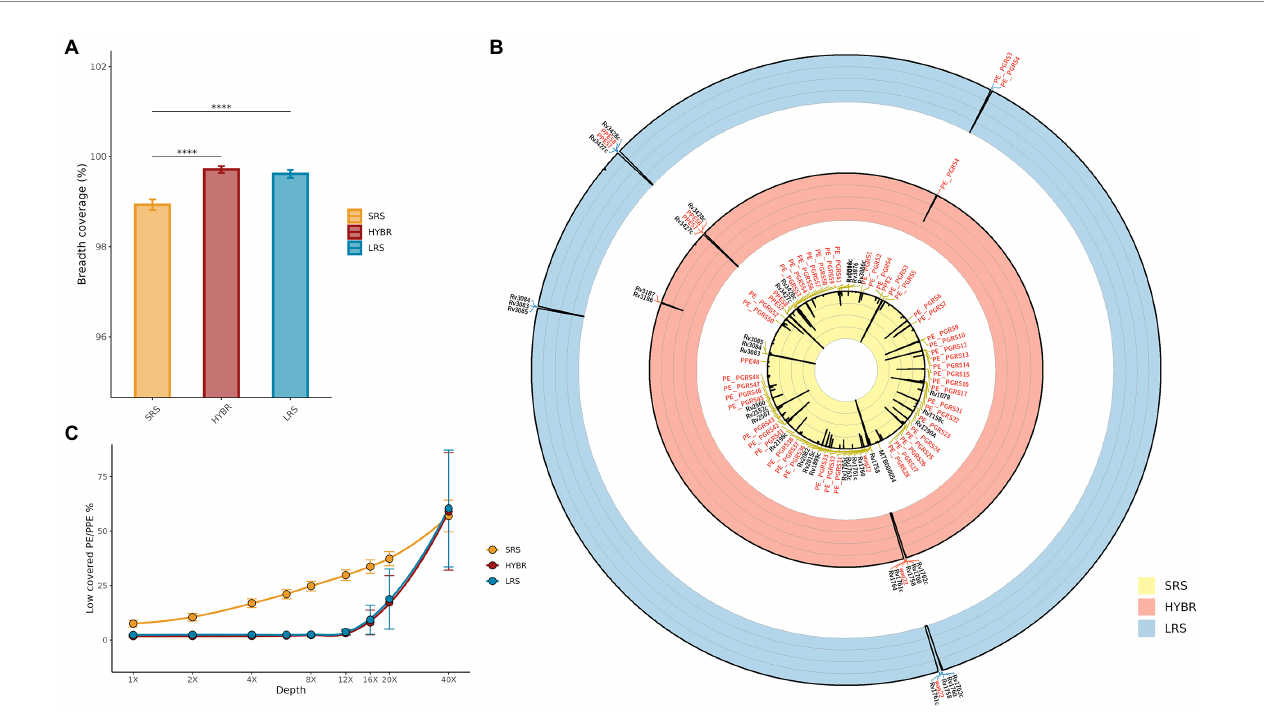
FIGURE 2 (A) MTB genome breadth coverage at 8x. SRS—Yellow, HYBR—Red, LRS–Blue; (B) Approaches genome/genes breadth coverage Circos plot at 8x. Outer to inner: Blue—LRS; Red—HYBR; Yellow—SRS. Genes with a breadth coverage lower than 90% were annotated (in red PE/PPE genes). The black line represents the 8x breadth coverage percentage at that position (0% inner–100% outer); (C) Number of low-covered PE/PPE genes at different levels of depths. Blue— LRS; Red—HYBR;